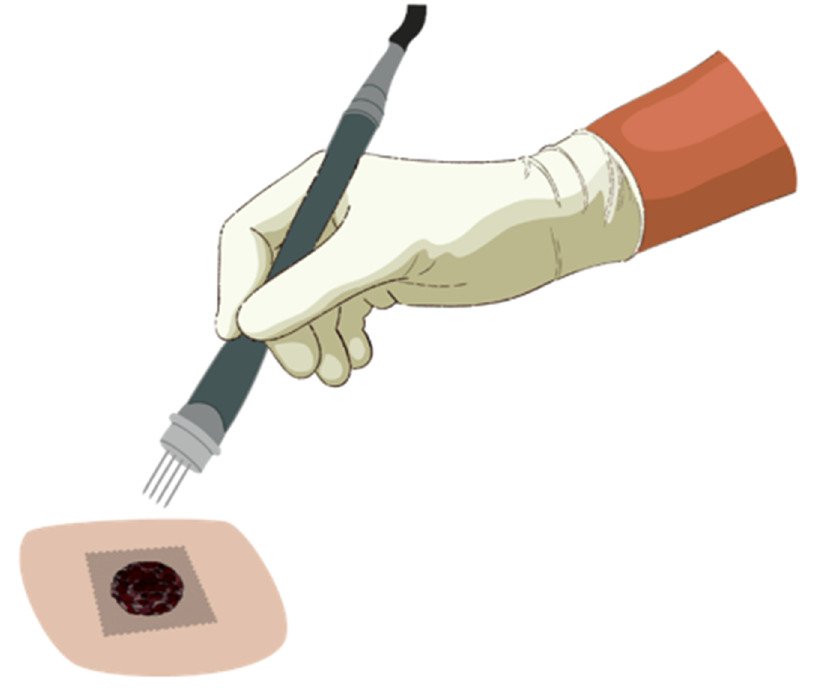
Figure 2. Application of electrochemotherapy in a tumor. After drug administration, the electric pulses are delivered by electrodes in contact with the tumor. The electrodes must be systematically moved to the adjacent area, and pulses applied again until the entire tumor area is covered. In the image, a model of needle electrode is exemplified.